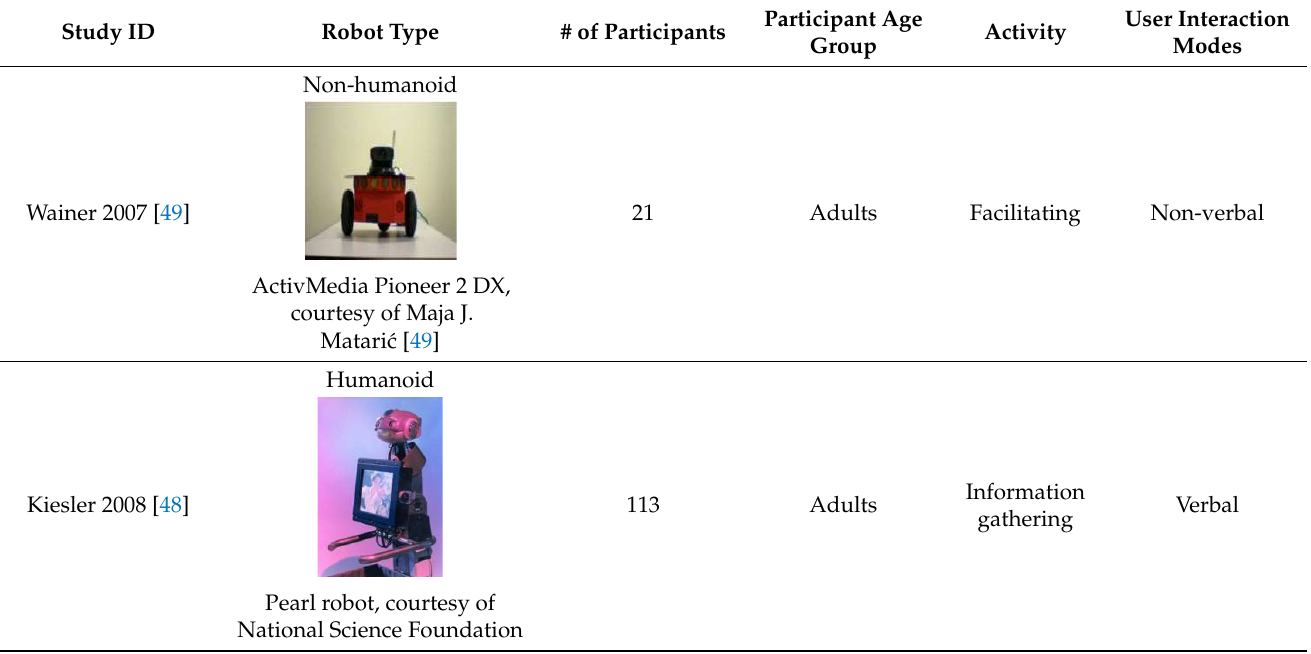
Figure 2. Flowchart of study selection procedure. Table 1. Summary of the Remote and In-person HRI Studies.